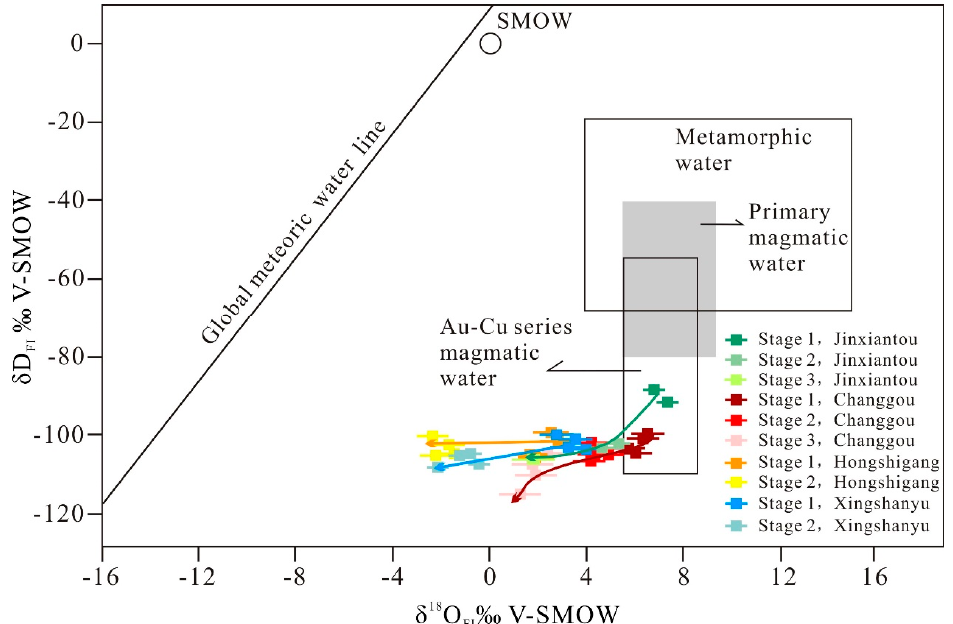
Figure 12. Plot of δ D vs. δ 18 O for fluid inclusions in quartz representing the different mineralization stages of the four deposits in the Qibaoshan polymetallic ore field. The fields for metamorphic, primary magmatic waters and global meteoric water line are from Taylor [32]. The field for Au–Cu series magmatic water is from Zhang [45].